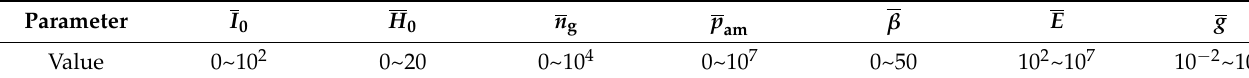
Table 2. Dimensionless parameters.